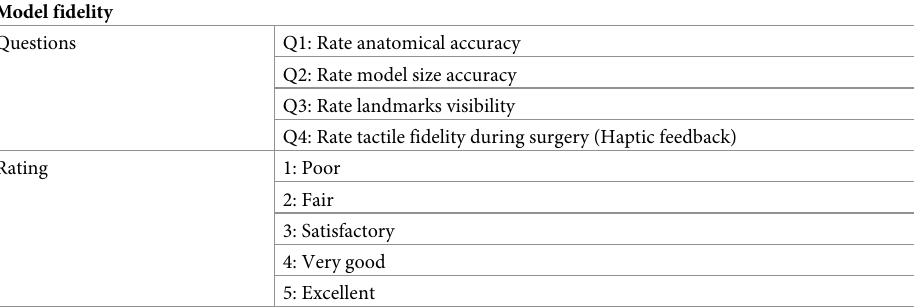
Table 1. Outline of survey questions: Model